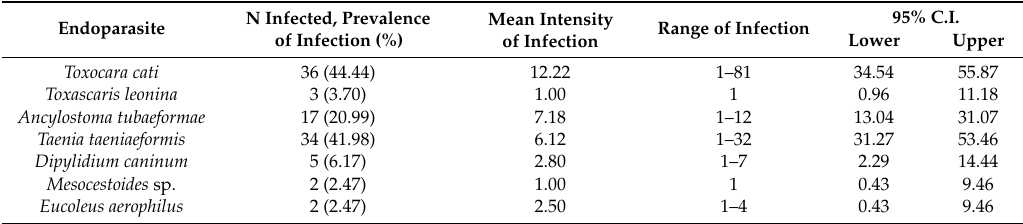
Table 1. Prevalence (%) and intensity of parasitic infections of studied cats.